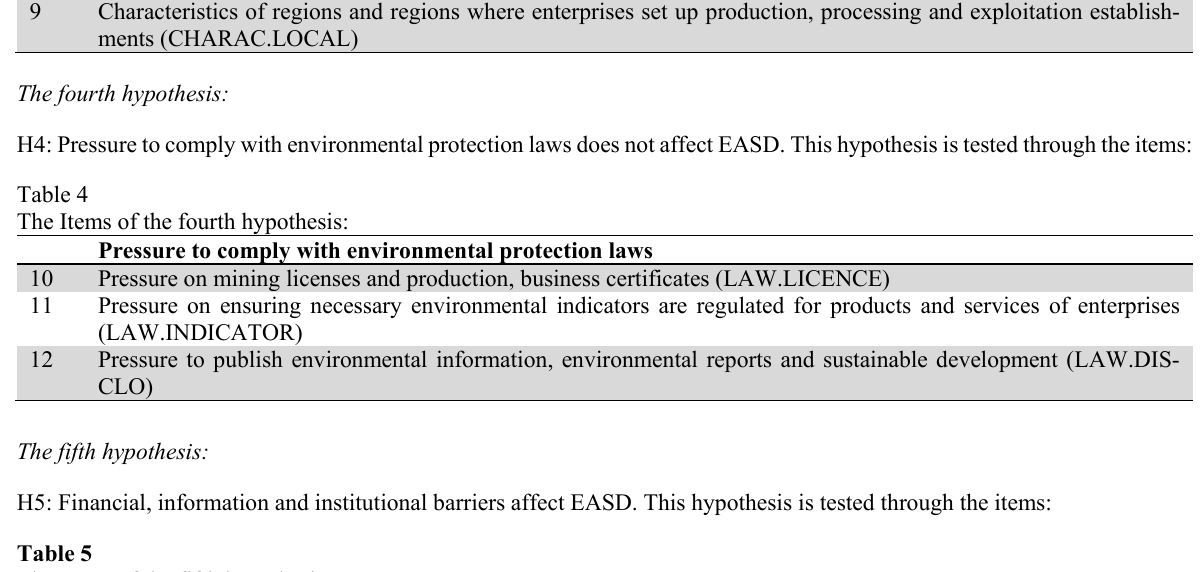
The Items of the fifth hypothesis: Financial, information and institutional barriers 13